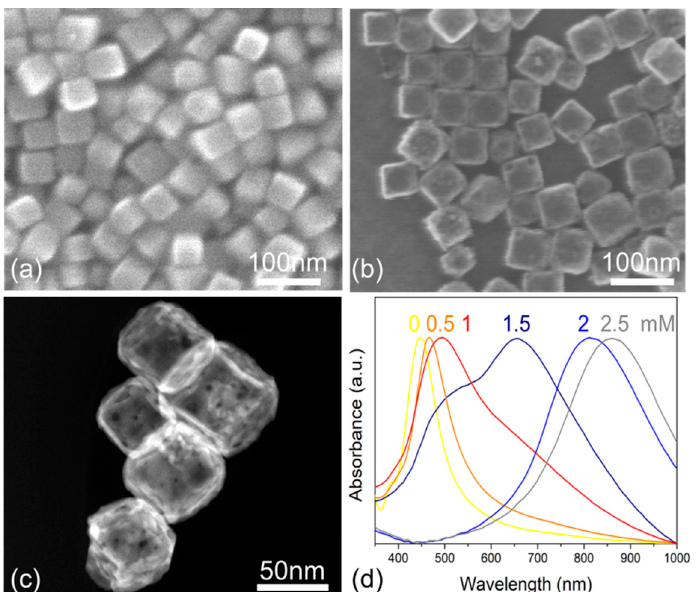
Figure 1. Images and optical properties of AgNCs and AuNCs. ( a ) SEM image of AgNCs, which showed approximately 50 nm in edge length. ( b ) SEM image and ( c ) TEM image of AuNCs showing a hollow and porous structure. ( d ) UV-visible-NIR absorbance spectra of AgNCs and AuNCs by adding different volumes of HAuCl 4 solution (0, 0.5, 1, 1.5, 2, 2.5 mM).